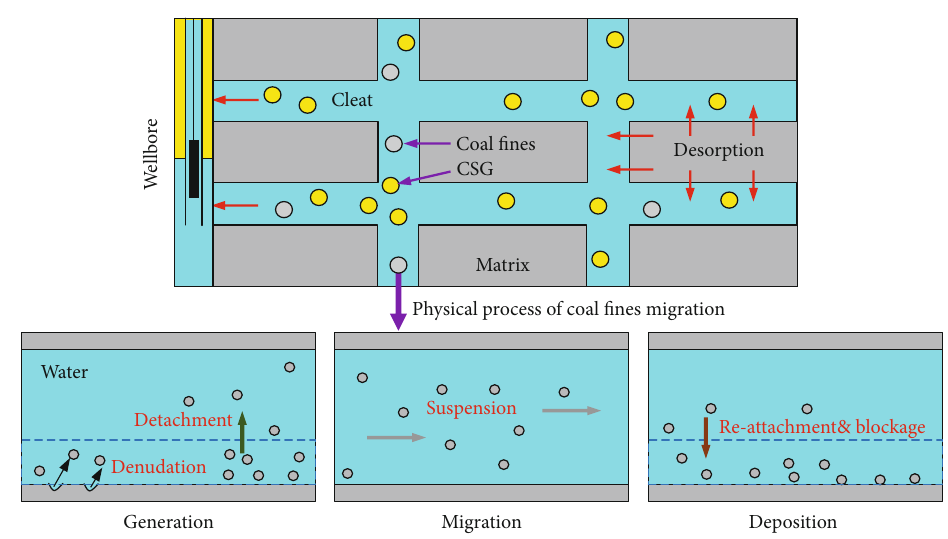
Figure 1: The fl ow stages and physical processes of coal fi nes during the production